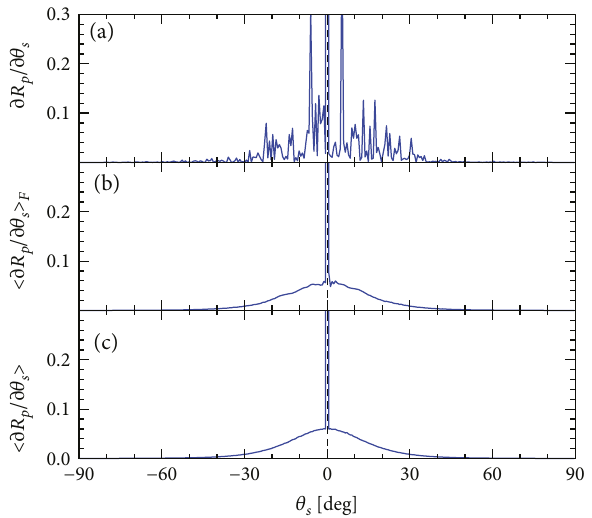
Figure 2: The di ff erential re fl ection coe ffi cient ∂ R (17) for a vacuum-glass system [ ε 1 = 1 and ε 2 = 2 25 ] illuminated from the vacuum side by di ff erent p-polarized incident beams: (a) a Gaussian monochromatic beam of halfwidth w and frequency ω ; (b) a broadband Gaussian beam of center frequency ω 0 frequency bandwidth Δ ω = 0 2 ω 0 ; and (c) a monochromatic beam as in Figure 2(a) but with an average performed over an ensemble of N =10,000 realizations of the interface pro fi le function. The p angle of incidence was θ 0 = 0 ° and the wavelength was λ ω =632 . 8nm. The randomly rough interface was characterized by 0 the parameters δ = 0 15 λ 0 , a = 1 50 λ 0 , and L = 10 4 λ 0 , and the sampling interval used to discretize the surface was Δ x 1 = λ 0 /10 . For the width of the Gaussian beam, the value w = L /4 was used. The same random interface was used in producing the results of the fi rst two panels of this fi